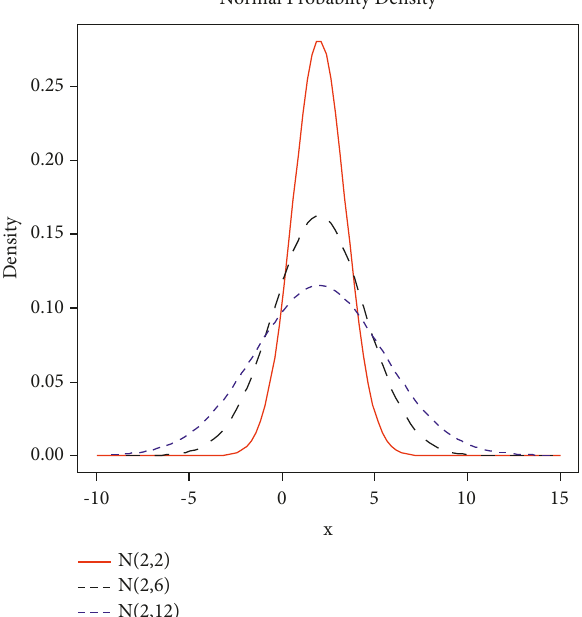
Figure 2: Normal probability density with parameters ( μ , σ 2 ) as N ( 2 , 2 ) , N ( 2 , 6 ) , and N ( 2 , 12 ) . Table 1: The range of the fixed confidence interval depended on P